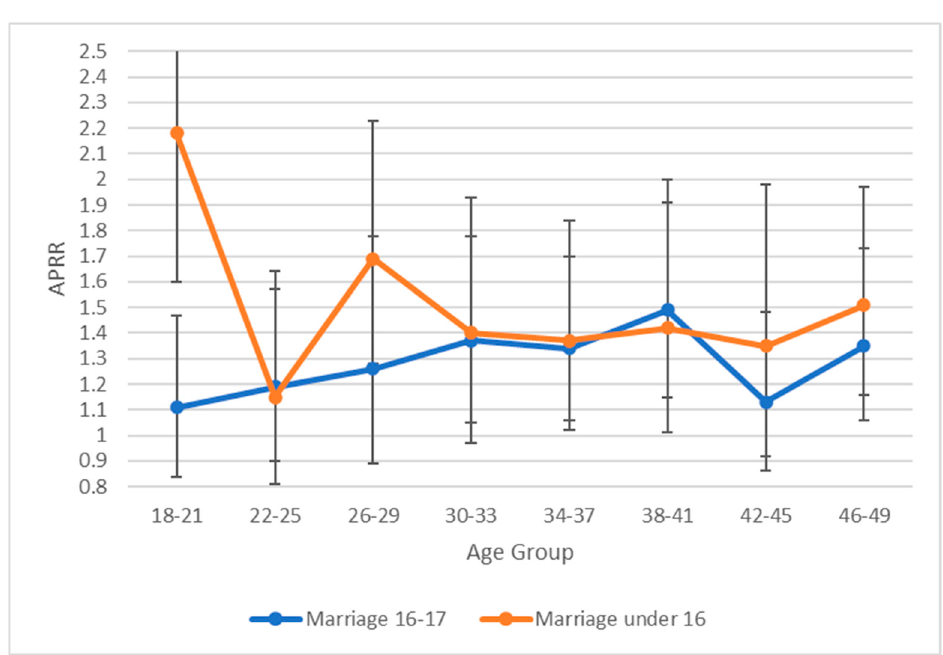
Figure 1. Prevalence rate ratios with 95% CIs (adjusted for within age group variation in age) for women with disabilities having been exposed to child marriage at age 16–17 and under 16 by age group.